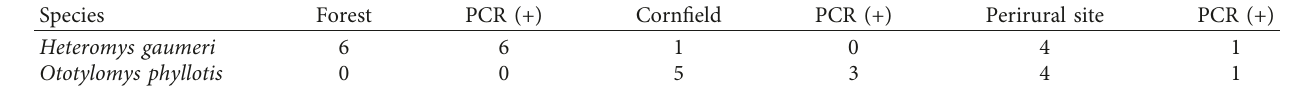
Table 2: Distribution of rodent species with Leishmania infection by trapping